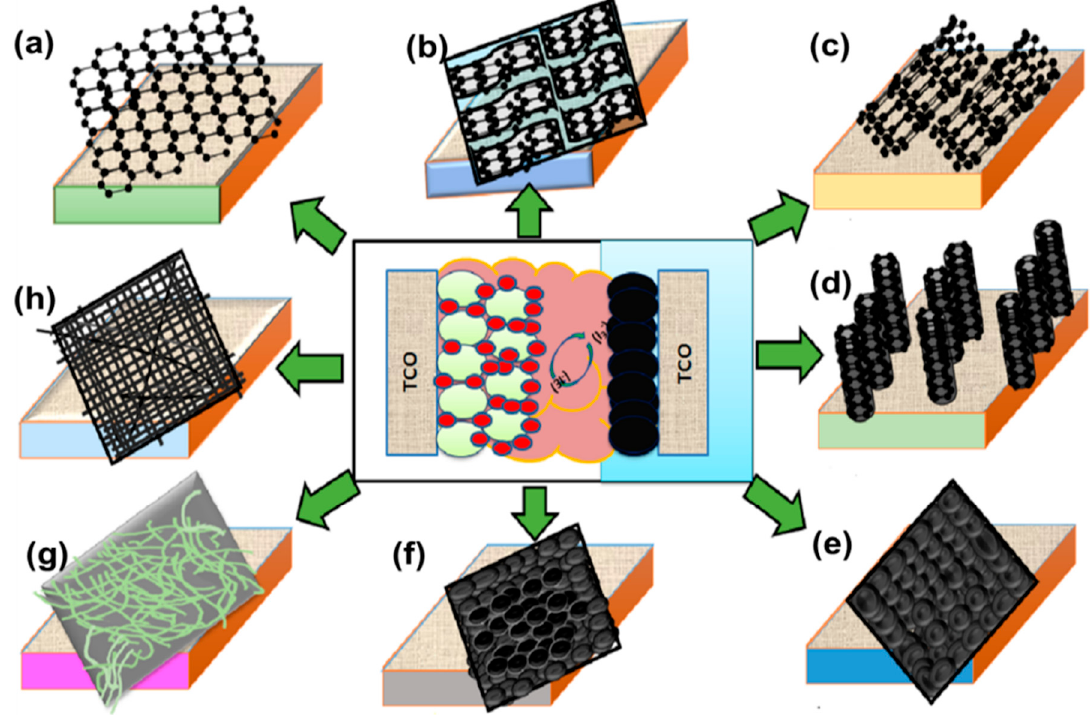
Figure 5. Schematic diagrams showing di ff erent types of carbon materials used as CEs in DSSCs: ( a ) graphene, ( b ) graphite, ( c ) randomly oriented carbon nanotubes (CNTs), ( d ) one-directional CNTs, ( e ) carbon black, ( f ) activated carbon, ( g ) carbon nanofibers (CNFs), and ( h ) hollow active CNFs.